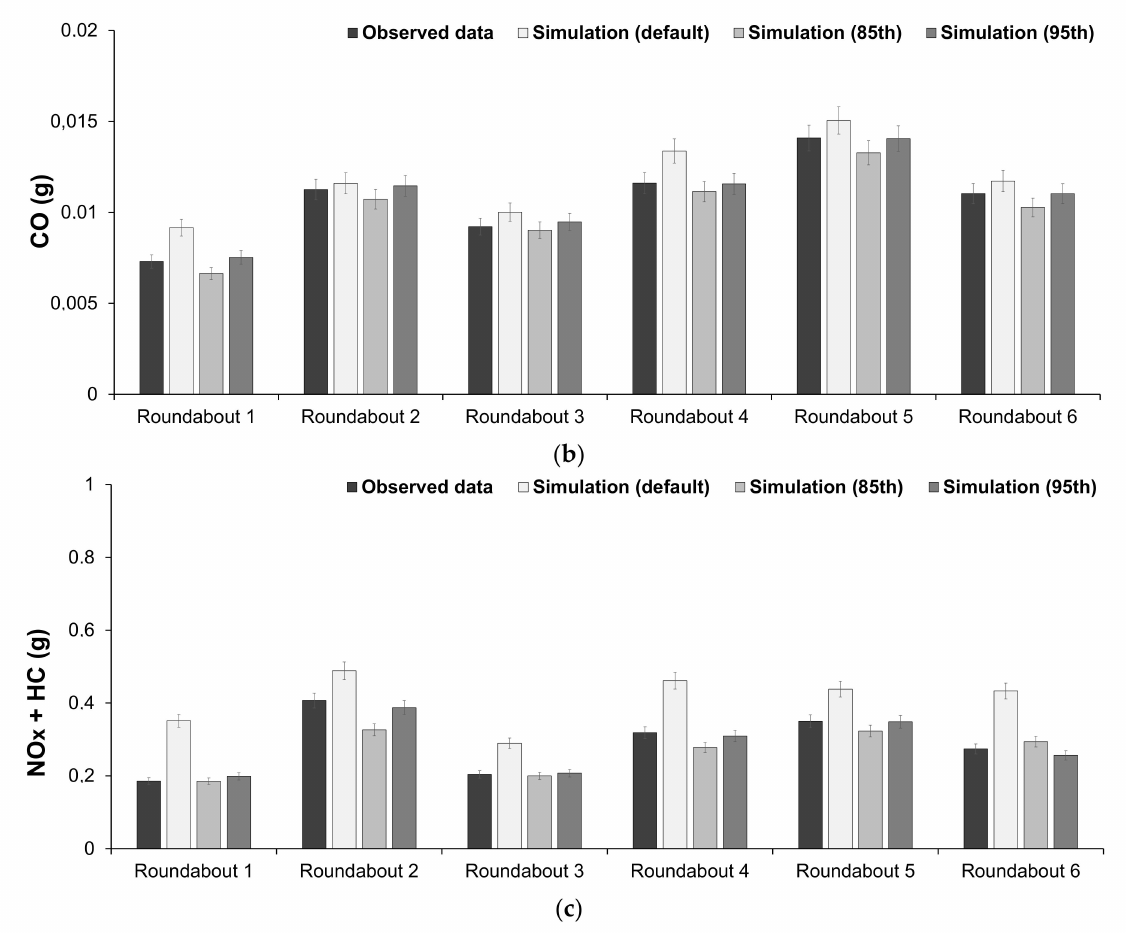
Figure 9. Observed versus simulated emissions at sampled roundabouts (through movements): ( a ) CO 2 ; ( b ) CO; ( c ) NOx +